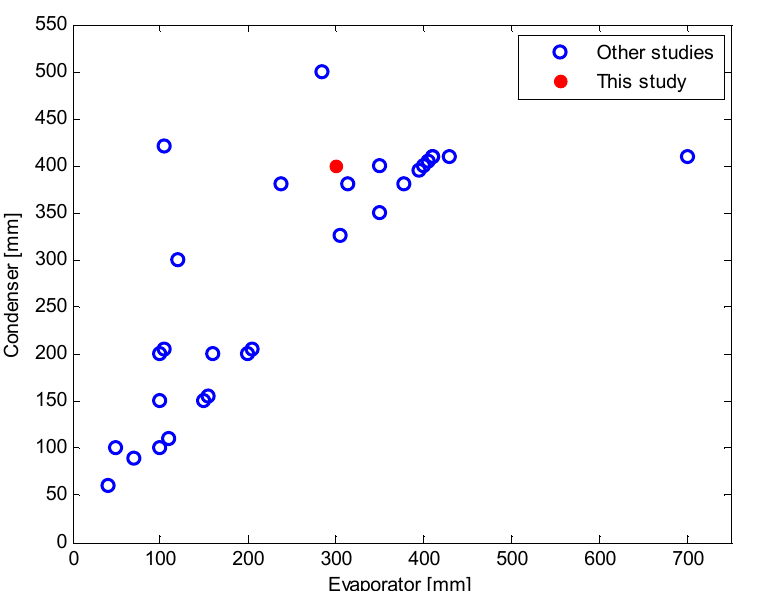
Figure 5. Experimental apparatus [9].